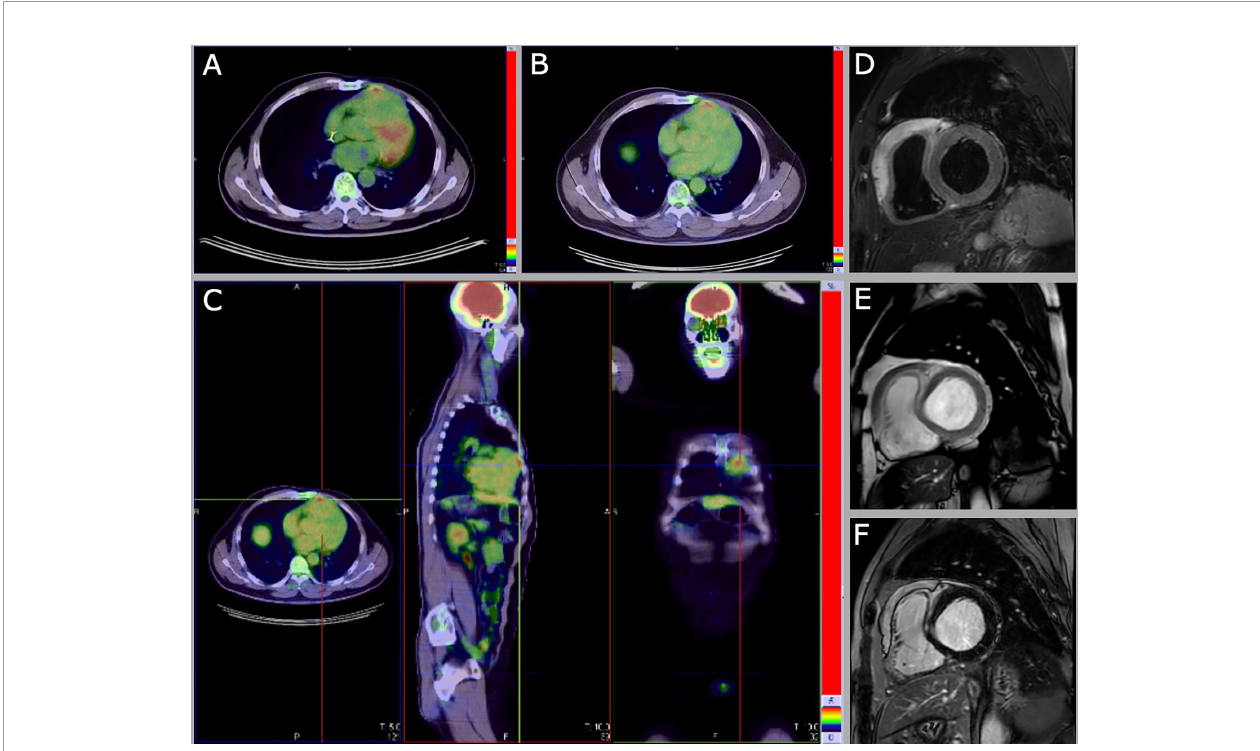
FIGURE 1 | CT-PET abnormal 18-FDG uptake on right ventricle thickening 3 months (SUV 4.9, DS 4) (A) and 18 months (SUV 5 – DS 4) (B, C) after ASCT. Cardiac MRI images of June 2019 (from D to F ) show the persistence of the right ventricle anterior wall thickening (14x56 mm). (D) Short tau inversion recovery (STIR) T2 black blood image in short axis on the cardiac base. (E) Steady-state free precession (SSFP) balance image with T2/T1 weighting in short axis on the cardiac base. (F) IR TSET1 image for evaluation of myocardial late enhancement in short axis on the cardiac